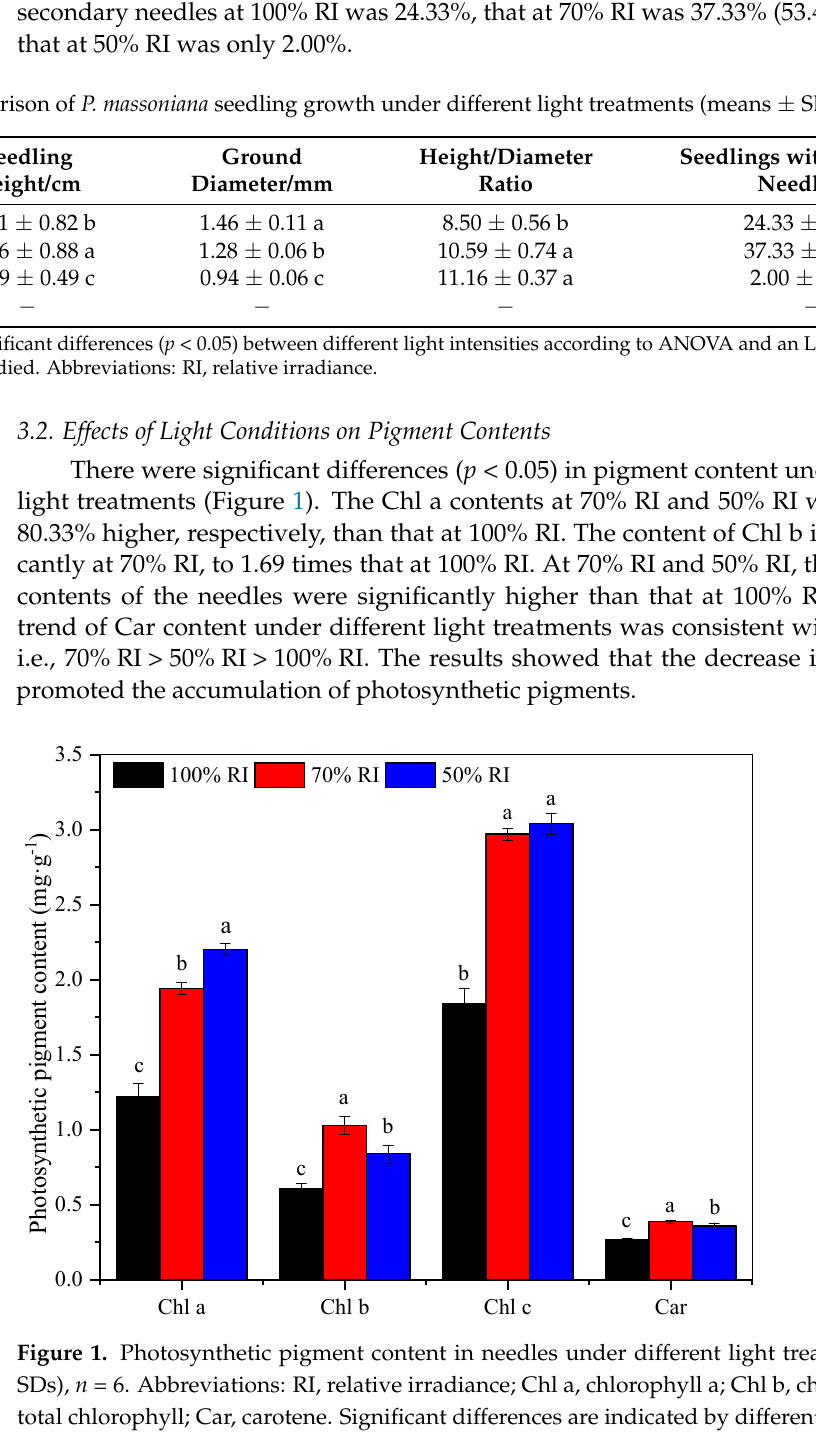
Table 2. Comparison of P. massoniana seedling growth under different light treatments (means ± SD). Treatment